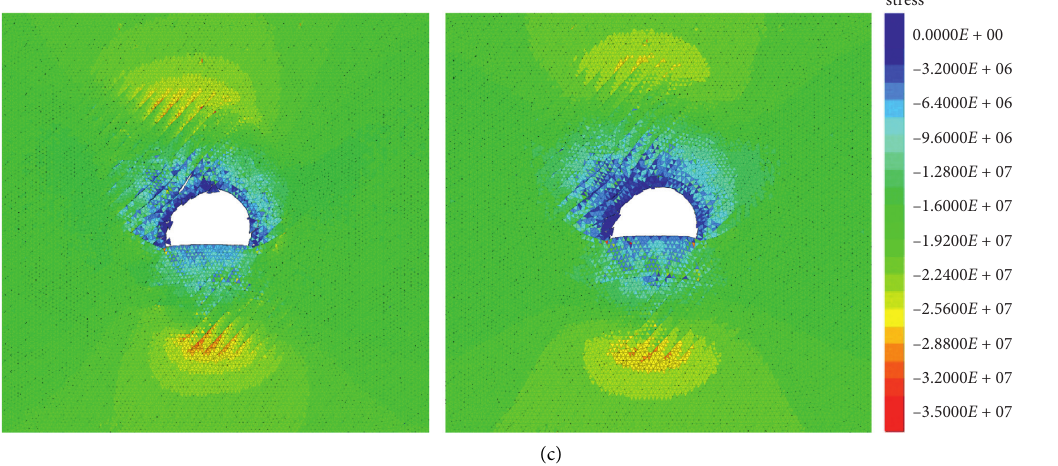
Figure 14: Deformation characteristics of the surrounding rock of the tunnel under water absorption and softening: (a) change in the surrounding rock displacement before and after water absorption, (b) changes in the plastic zone of the tunnel before and after water absorption, and (c) changes in the maximum principal stress field of the tunnel before and after water